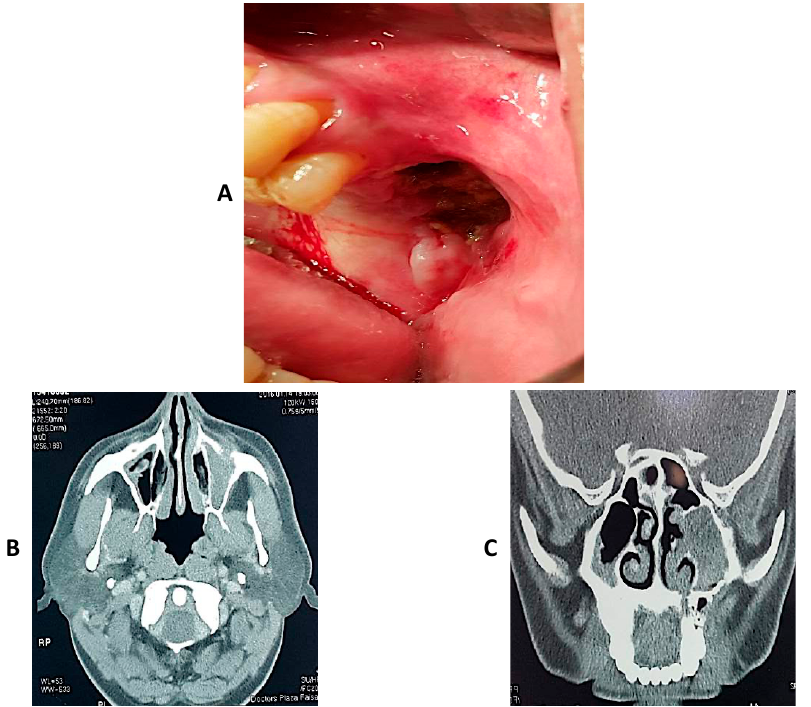
Figure 4. Picture A, showing exposed necrotic bone in the left posterior maxilla ( A ). The axial ( B ) and coronal ( C ) slices of contrast enhanced CT scan showing bone destruction, sequestrum formation, sinus opacification, and involvement of the nasal turbinates.